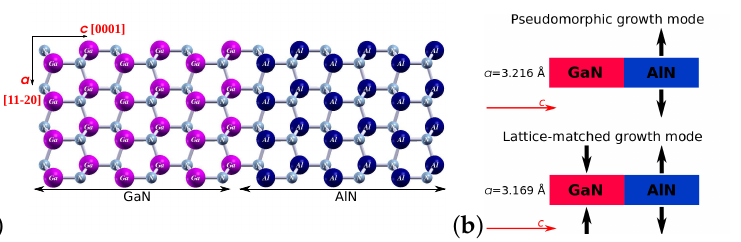
Figure 1. ( a ) The model of AlN/GaN superlattice, ( b ) schemes of the two growth modes of AlN/GaN heterointerface. Large violet and navy blue balls represent Ga and Al atoms, respectively, while small grey balls denote N atoms.